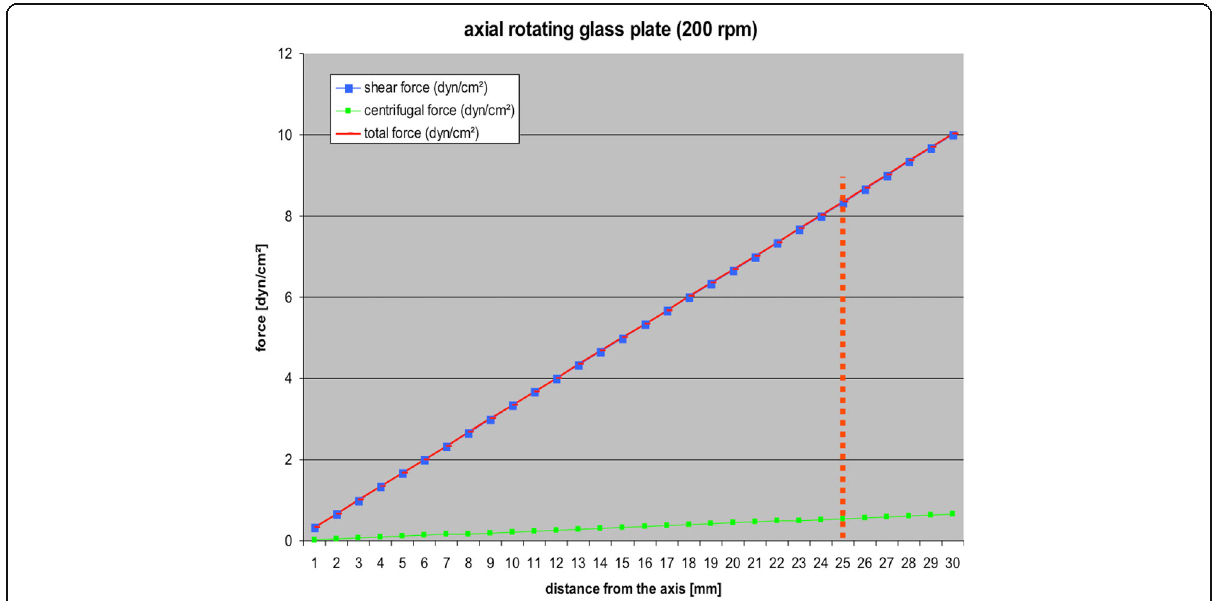
Fig. 3 Diagram for visualisation of the calculation of shear stress rates taking into account the centrifugal force and the glass plates ’ dimensions. For example, at a distance of 25 mm from the centre of the upper plate, the shear forces ’ value is 8.33 dyn/cm 2 , together with an additional centrifugal force that has a value of 0.55 dyn/cm